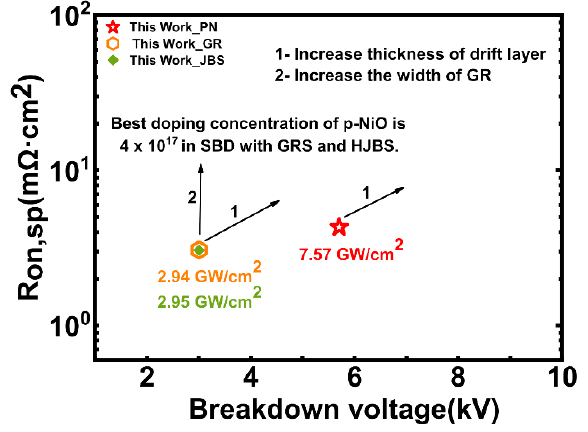
Figure 14. DC Ron,sp–BV benchmark comparison some design methods.